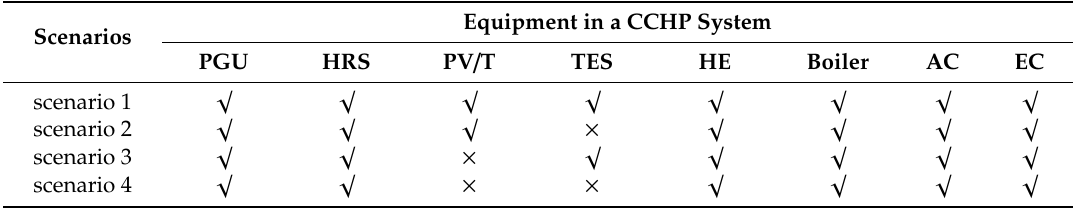
Table 4. Di ff erent scenarios of di ff erent configuration in CCHP